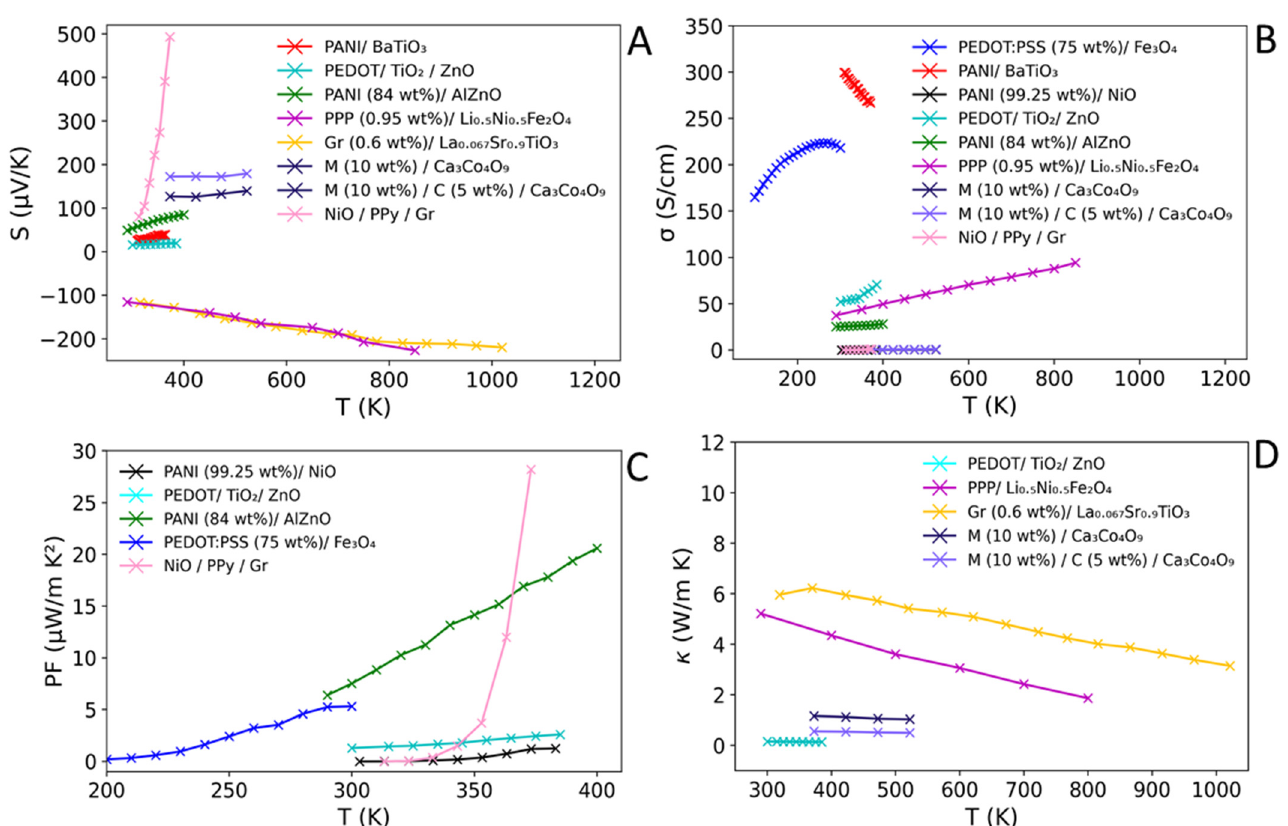
Figure 6. Comparison of TE parameters of oxide/polymer composites as a function of temperature (T). ( A ) S . ( B ) 𝜎 . ( C ) PF. ( D ) 𝜅 . PANI/BaTiO 3 [188], PEDOT/TiO 2 /ZnO [189], PANI (84 wt%)/AlZnO ( A ) S . ( B ) σ . ( C ) PF. ( D ) κ . PANI/BaTiO 3 [188], PEDOT/TiO 2 /ZnO [189], PANI (84 wt. %)/AlZnO [190], [190], PPP (0.95 wt%)/Li 0 . 5 Ni 0 . 9 Fe 2 O 4 [196], Graphene (0.6 wt. %)/La 0 . 067 Sr 0 . 9 TiO 3 [31], PEDOT:PSS (75 PPP (0.95 wt. %)/Li 0.5 Ni 0.9 Fe 2 O 4 [196], Graphene (0.6 wt. %)/La 0.067 Sr 0.9 TiO 3 [31], PEDOT:PSS wt. %)/Fe 3 O 4 [192], PANI (99.25 wt. %)/NiO [191], M(10 wt. %)/Ca 3 Co 4 O 9 , M(10 wt. %)/C (5 wt. (75 wt. %)/Fe 3 O 4 [192], PANI (99.25 wt. %)/NiO [191], M (10 wt. %)/Ca 3 Co 4 O 9 , M (10 wt. %)/C %)/Ca 3 Co 4 O 9 [194], and NiO/PPy/Gr [195]. M = Matrimid, C = carbon black. (5 wt. %)/Ca 3 Co 4 O 9 [194], and NiO/PPy/Gr [195]. M = Matrimid, C = carbon black. The n-type composite material containing the NAr polymer PPP, 0.95 wt. % PPP/Li 0.5 Ni 0.5 Fe 2 O 4 , shows the highest thermopower ( S ), comparable to